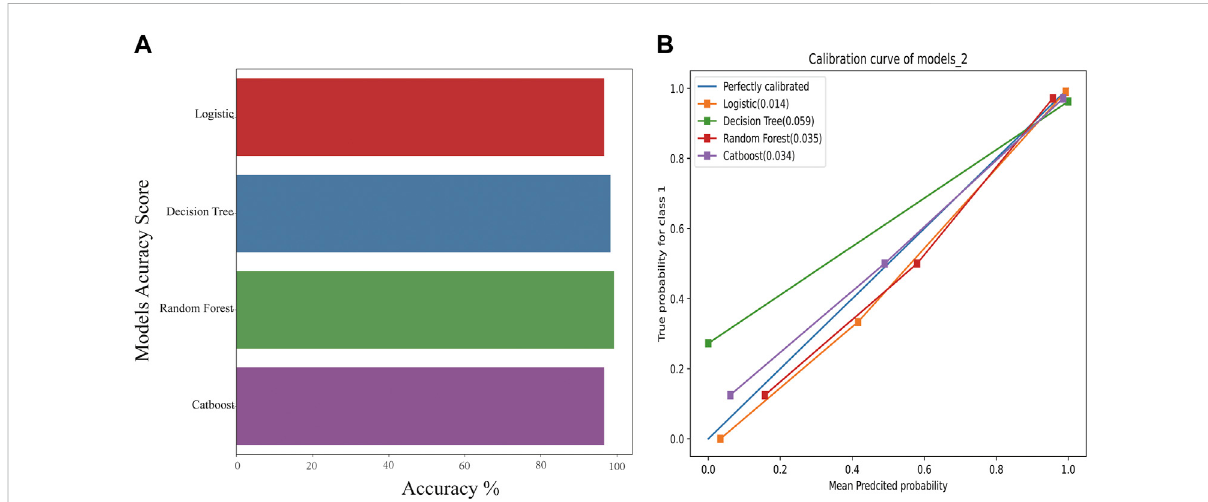
FIGURE 3 The accuracy scores of models and their calibration curves. (A) : Accuracy scores of models constructed using machine learning. (B) : The calibration curve of models is shown in Figure 3B. The diagonal line is the reference, i.e., the case where predicted value = actual value. If predicted value = observed value, the calibration curve coincides exactly with the reference. If predicted value > observed value, wherein the risk is overestimated, the calibration curve is below the reference. If the predicted value is less than the observed value, wherein the risk is underestimated, the calibration curve is above the